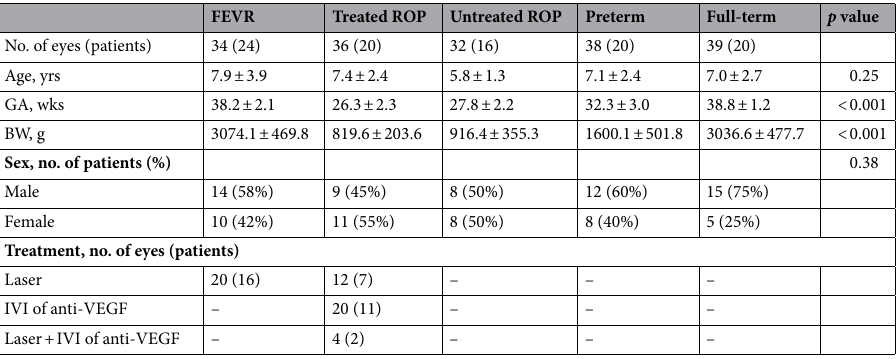
FEVR (1) Treated ROP (2) Untreated ROP (3) Preterm (4) Full-term (5) p value Post hoc a Uncorrected log- MAR